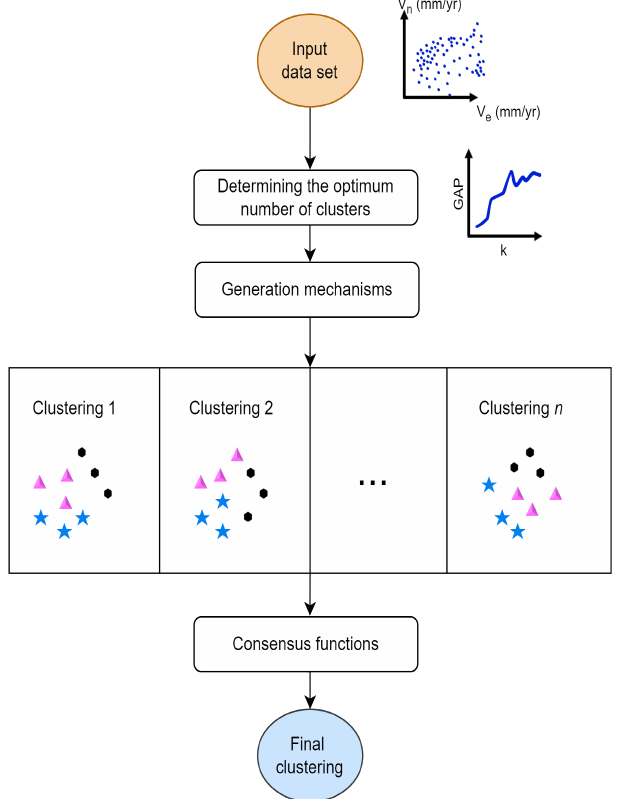
Figure 2. The flowchart of this